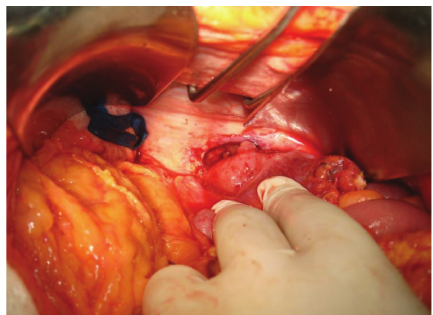
Figure 4: Intraoperative image of the loft colon perforation.